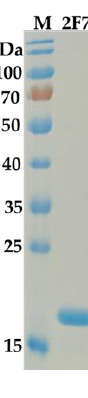
Figure 4. Characterization of nanobodies by SDS-PAGE.